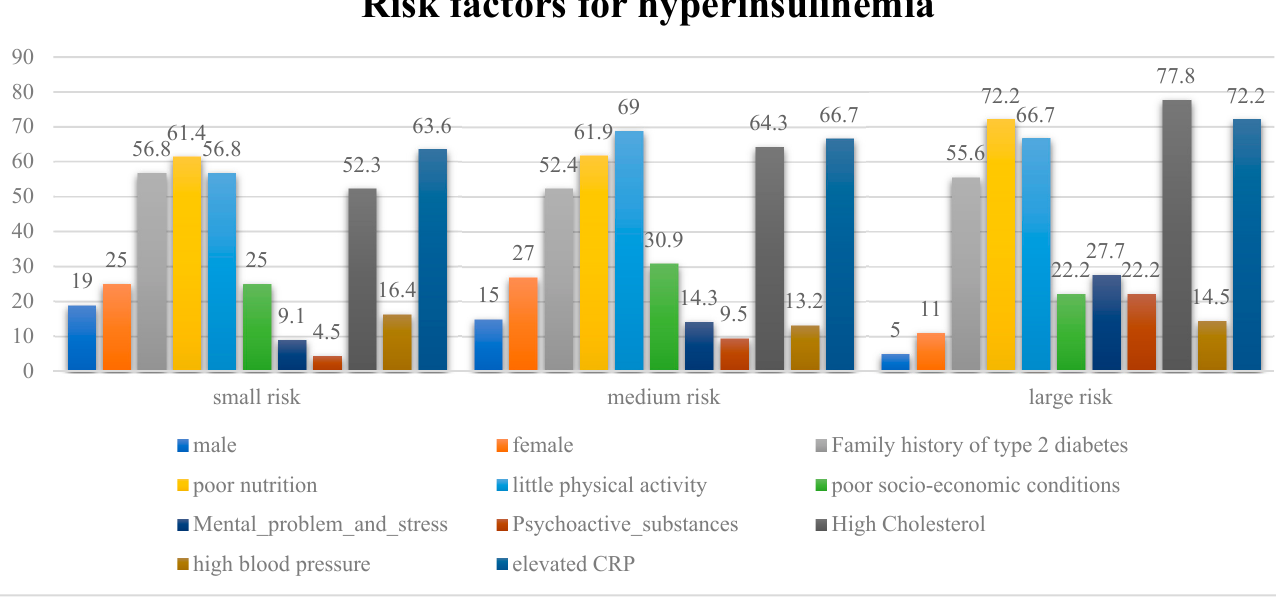
Figure 5. Risk factors for hyperinsulinemia.